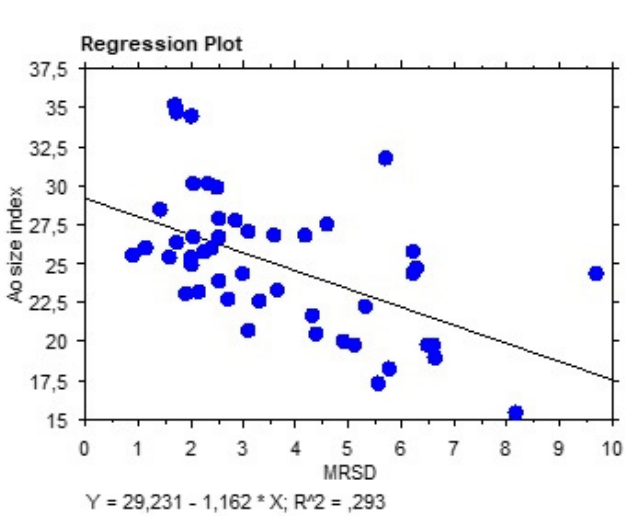
Fig. 3 – Regression plot showing a significant correlation between maximal rate of systolic distension (MRSD) and aortic size index.